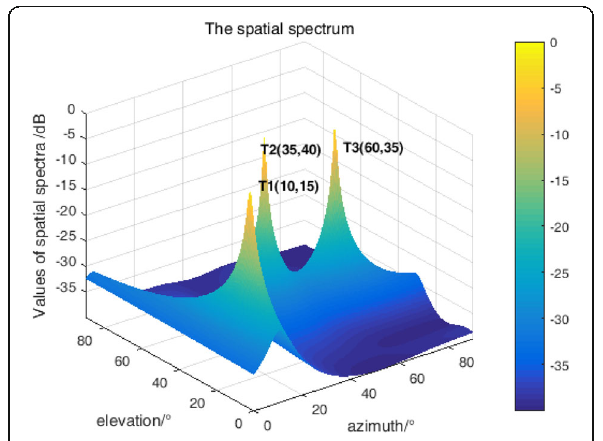
Fig. 5 The spatial spectrum of the proposed algorithm Fig. 6 RMSE versus SNR with the snapshots being